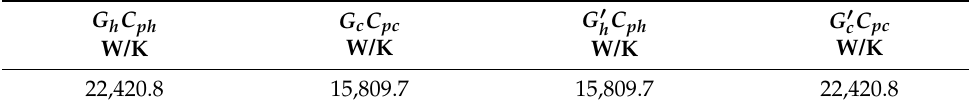
Table 4. Heat capacity rates of the streams in the helical steam generator studied.